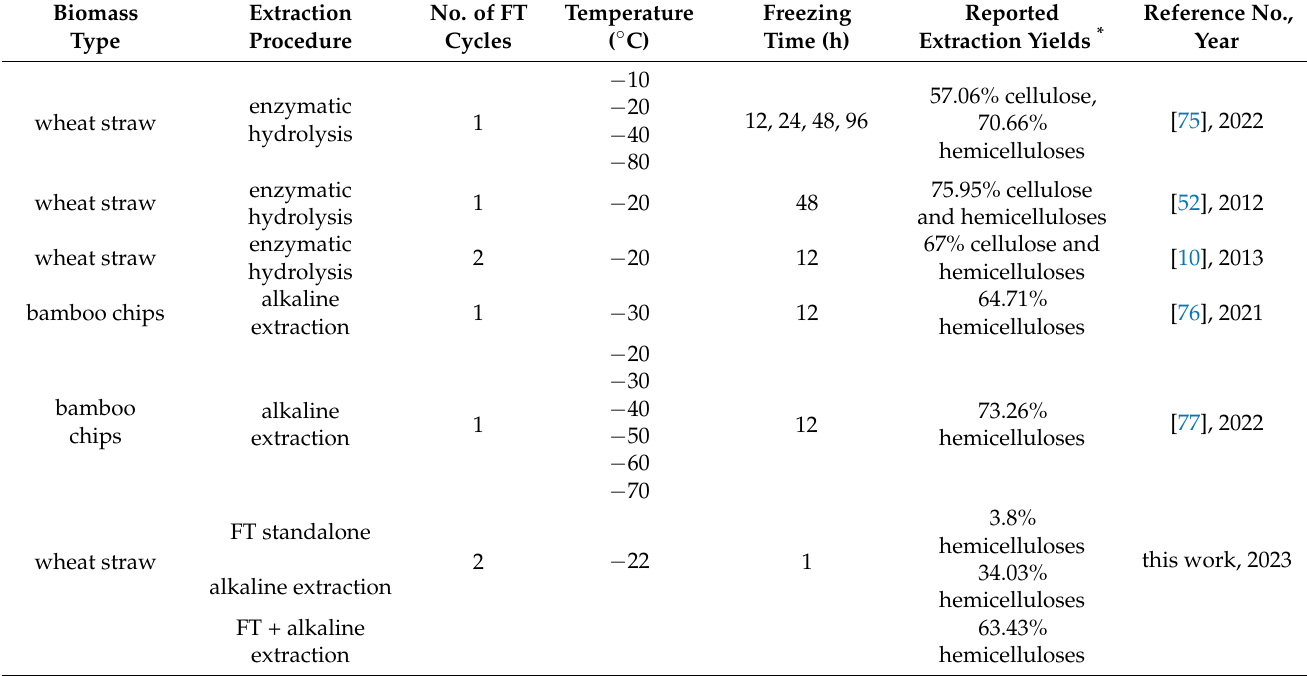
Table 7. Comparison of freeze–thaw enhancement of agro-waste biomass